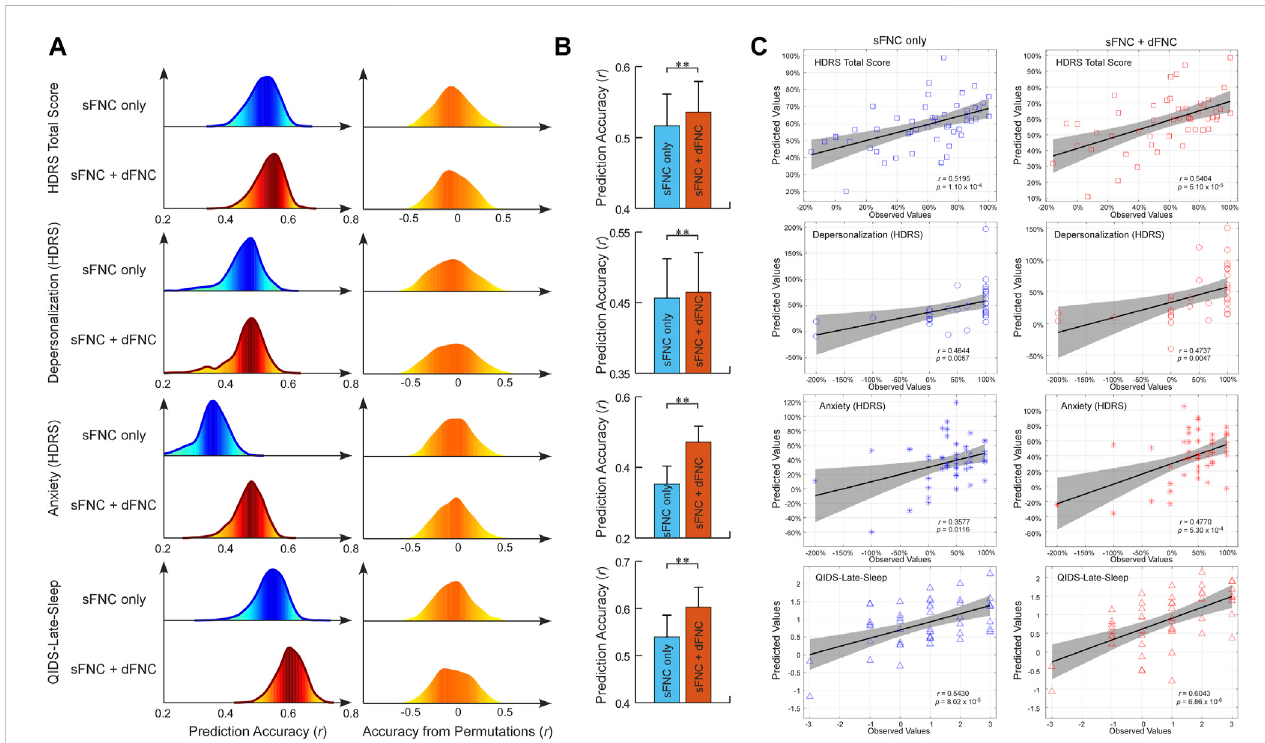
FIGURE 2 FNC-based prediction results for antidepressant outcomes induced by ECT. (A) Distribution of prediction accuracies across 1,000 repetitions of cross- validation and distribution of accuracies based on permutation testing across 1,000 iterations. (B) Statistical analysis between prediction accuracies based on sFNC features only and based on combined features (sFNC+dFNC). (C) Scatter plot shows prediction of changes in HDRS 24 scores and QIDS score. Considering that the prediction framework was repeated 1,000 times, we only show results from the iteration with the median prediction